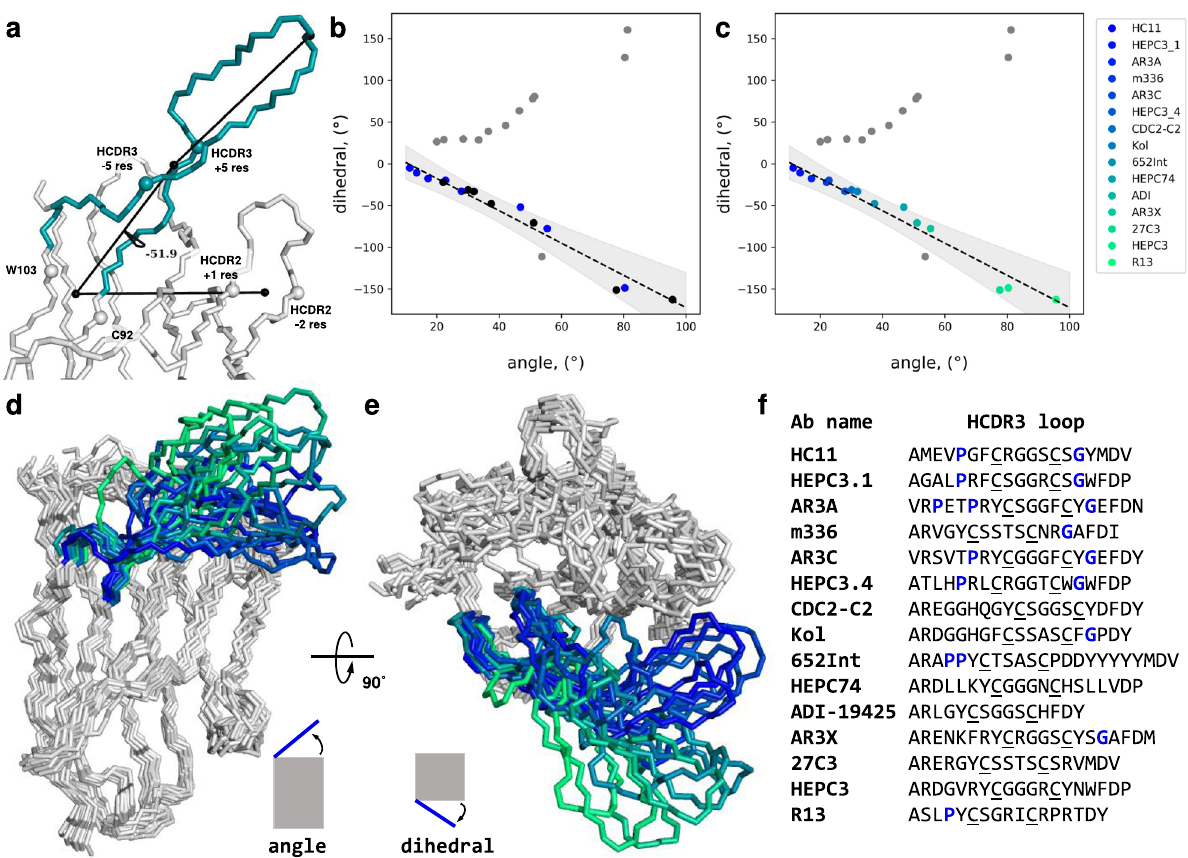
Fig. 5 Analysis of the Ab structures with an HCDR3 loop CXXXXC motif. a The four points on an Ab that were used for the description of the overall shape of the HCDR3 loops in the dataset on the example of HEPC74 (PDB ID 6MEE). The HCDR3 loop is colored. The C α atoms used for calculations are shown as spheres. The four calculated points are shown as black spheres and are connected by black lines. b , c Calculated angles and dihedrals for HCDR3 loops of all 27 found Abs. Source data are provided in the Source Data fi le. b The values for the HCV-speci fi c Abs are shown as blue dots. The unrelated Abs that are following the same trend as the HCV-speci fi c Abs are shown as black dots. Also shown are the estimated linear correlation curve (dashed line) for the proposed trend and + / − 3 σ uncertainty around the estimated curve (shadowed area). c The Abs that seem to follow the trend of the rigid body HCDR3 loop rotating away from the heavy chain and the Ab Fv region, in general, are color-coded based on the distance (blue — closer, green — further away). A side view ( d ) and a top view ( e ) on the aligned Fv regions of the Ab heavy chains. The HCDR3 loops are colored according to the legend on the panel ( c ). The ultra-long HCDR2 loop of AR3X is not shown. f Sequences of the HCDR3 loops (IMGT de fi nition) of the Abs shown on the panels ( d ) and ( e ). The two cysteines in each HCDR3 loop are underscored. Prolines in the fi rst half of the loop and glycines in the second half of the loop are colored